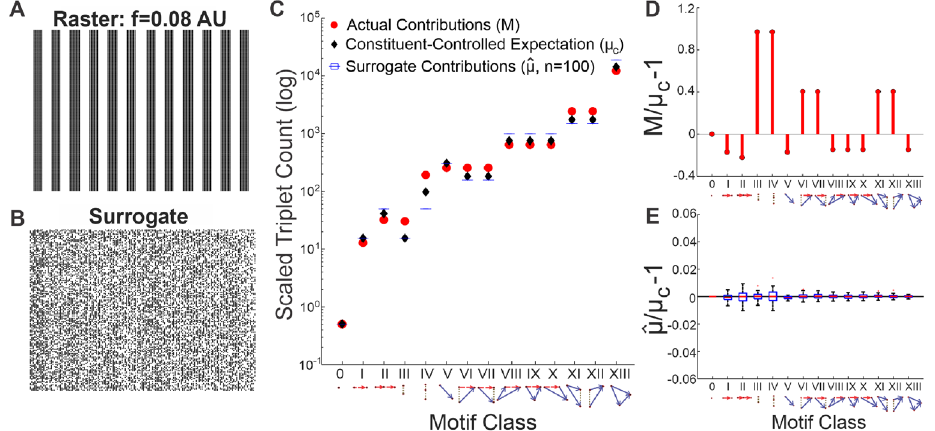
Figure 2. Motif-class contributions to the raster’s triple correlation. ( A ) A 150 × 150 spike raster generated by thresholding an 0.08 AU frequency sine wave. ( B ) Surrogate raster generated by randomly shuffling the periodic raster in (panel A ). ( C ) Various motif-class summary metrics calculated from a triple correlation using lags up to 20 bins in time and space: the actual contributions per motif class (M, red circles); the constituent- controlled theoretically expected contributions ( µ c , black diamond) conditioning on spike rate and controlling for the observed contributions of lower-order motifs; surrogate contributions ( ˆ µ c , blue boxplots visible as horizontal lines due to relatively small variance) the average motif-class contributions across n = 100 shuffled surrogate rasters. ( D ) The constituent-controlled ratios ( M /µ c − 1 ) per motif class. M /µ c − 1 for purely synchronous motif classes III and IV are highest; motif classes VI, VII, XI, and XII (which all consist an element of synchrony) also show positive M /µ c − 1 values. Note that motif class 0 always has zero signal because motif class 0 is the spike rate, which is controlled for by both N and T. ( E ) The estimated-to-constituent-controlled ratios ( ˆ µ/µ c − 1 ) for 100 noise simulations fluctuate around 0 for all motif classes and are shown as box-and- whisker plots. The centerline is the median, the bottom and top edges of the box are the first and third quartiles, and the whiskers extend to the minimum and maximum